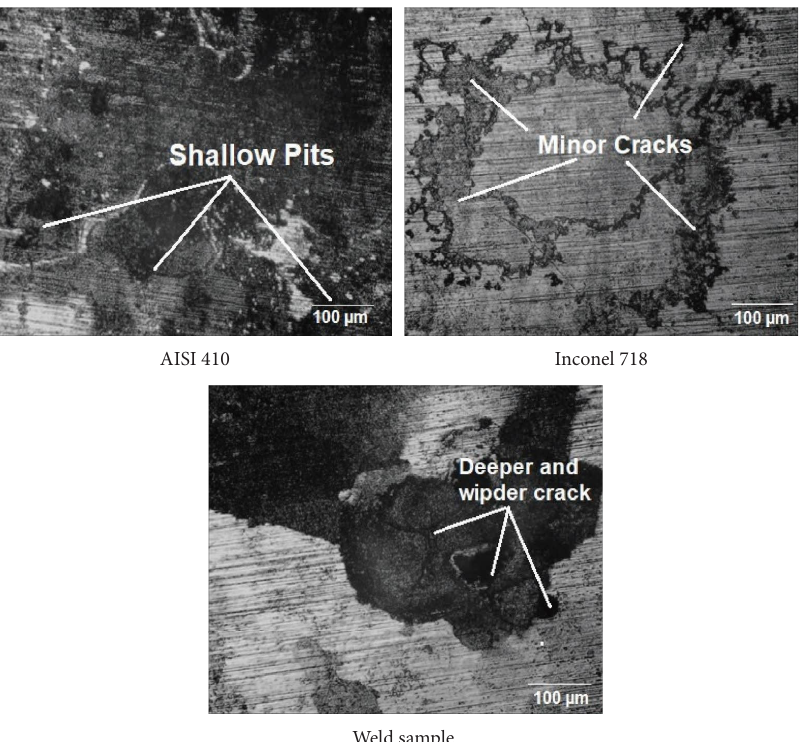
Figure 15: Corroded surface of base metal and weld